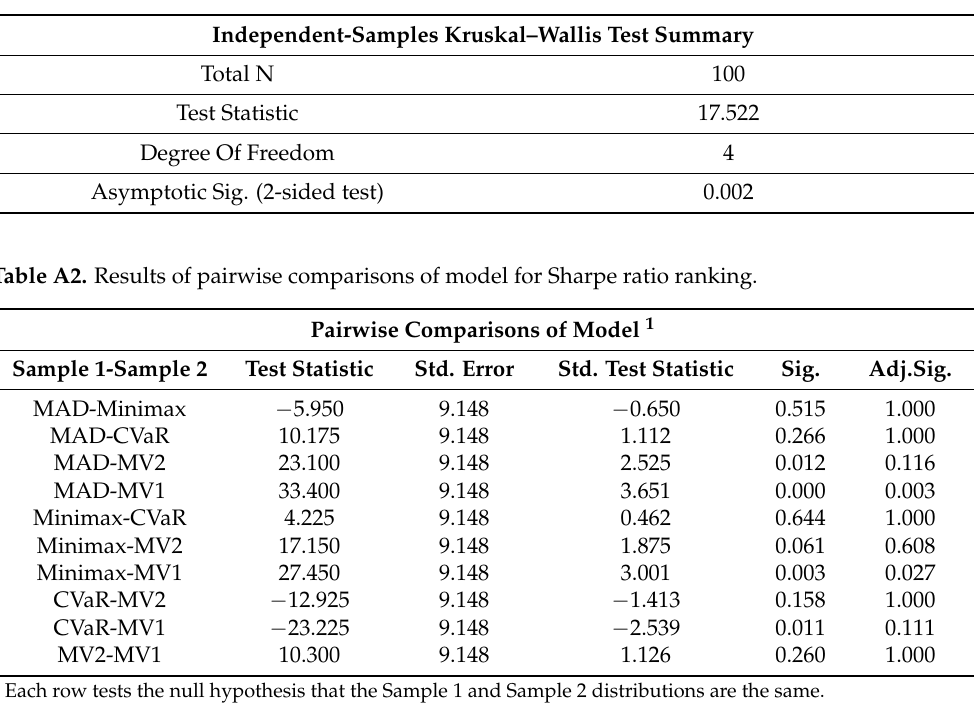
Table A1. Results of Kruskal–Wallis one-way ANOVA on ranks test for average number of stocks by portfolio.